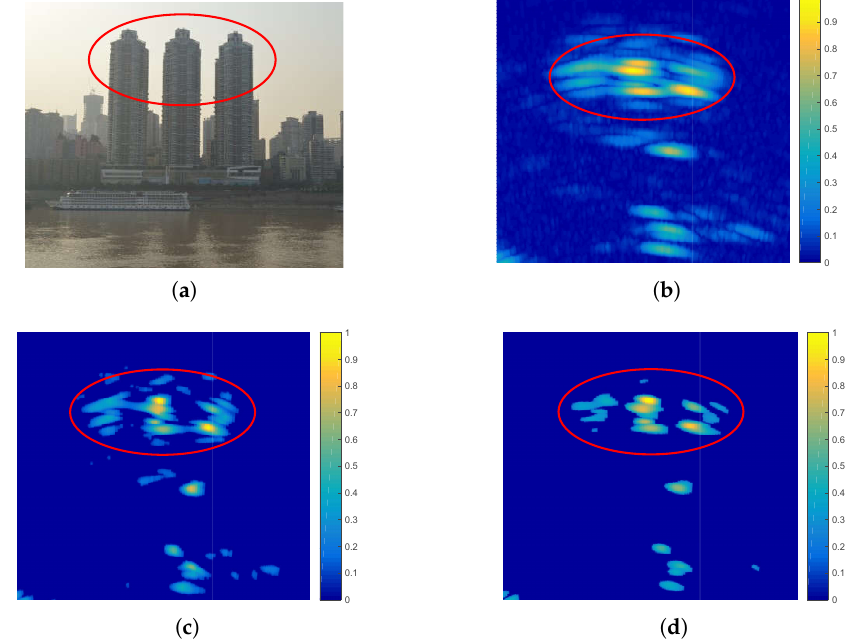
Figure 8. Processed results of real measured data. ( a ) The forward-looking imaging region of three buildings. ( b ) Real aperture image after pulse compression. ( c ) Superresolution result processed by the Poisson-based MAP algorithm. ( d ) Superresolution result processed by the proposed algorithm.